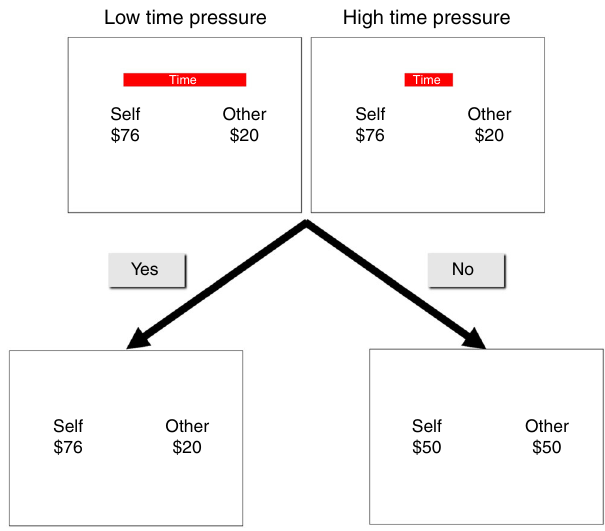
Fig. 1 Trial structure. Subjects saw a proposed monetary allocation for Self and Other under time pressure or not (indicated by a red bar) and chose whether to accept or reject the proposal. If they accepted, the proposal was implemented as shown. If they rejected, both they and their partner received a default of $50